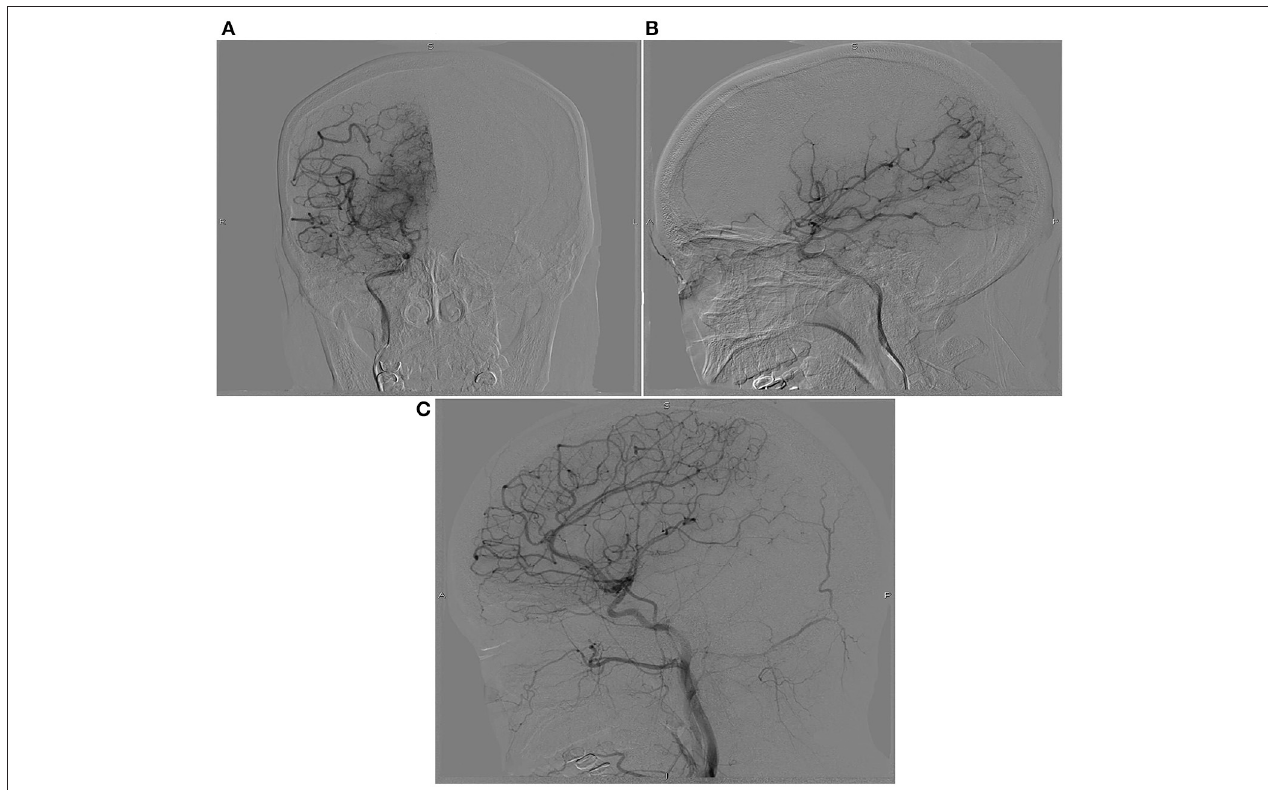
FIGURE 3 | Pre-treatment digital subtraction angiography imaging at anterior (A) , posterior (B) , and lateral (C) projections. Pre-treatment digital subtraction angiography imaging indicated hyperplastic angiography at the end of the internal carotid artery, resembles a puff of smoke rifting in the air.